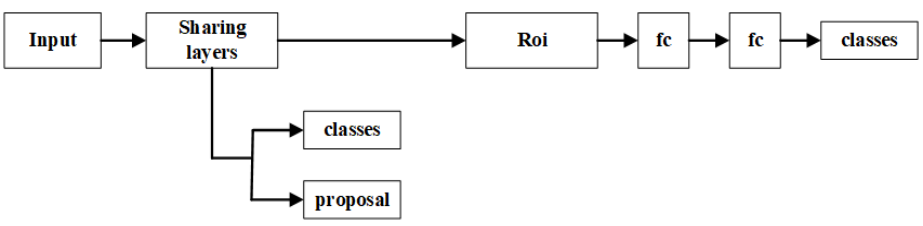
Figure 4. DCNet Training.